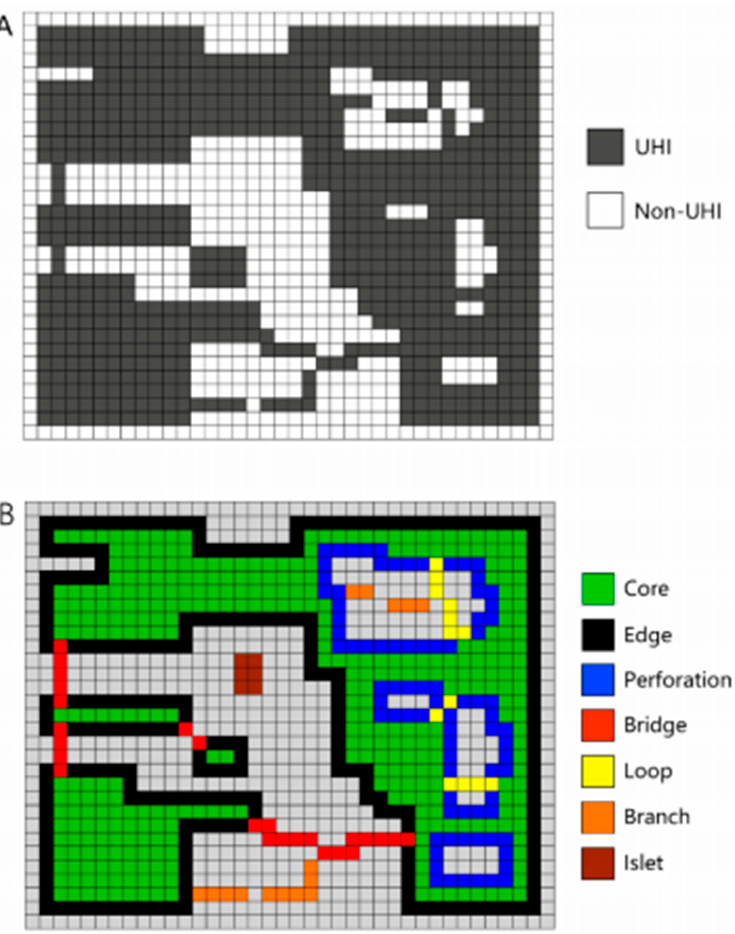
Figure 3. Basic forms identified by the MSPA analysis (core, islet, bridge, loop, branch, edge, and perforation areas. This image was adapted from the paper of Yu et al. [59] where the acronym UHI stays for Urban Heat Island but the concept can be easily generalized for any type of land cover map. ( A ) The image background pixel color is grey and identifies non-UHI, whereas the black pixel identifies UHI; ( B ) Different types of UHI in the context of the MSPA classification are shown.